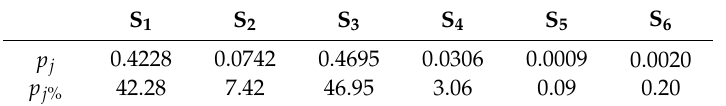
Table 10. Limit probabilities p j in the continuous physical time for the Markov process.